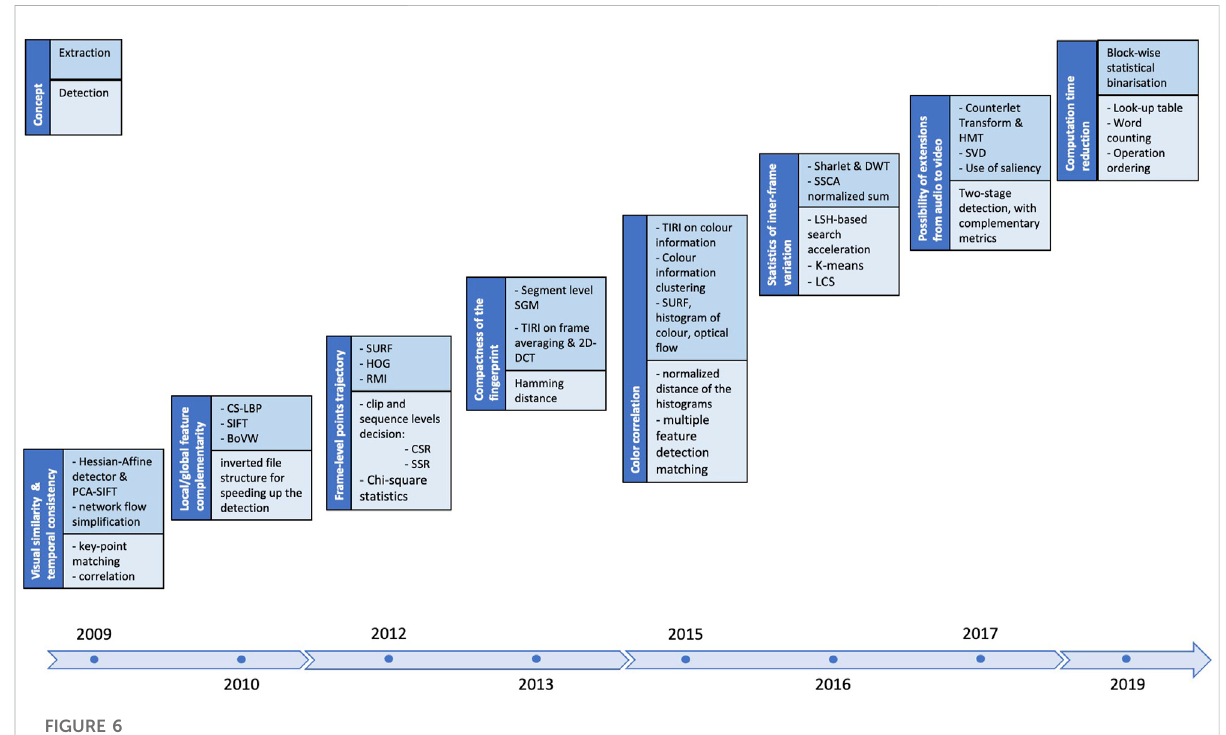
FIGURE 6 Incremental evolution of the conventional methods.